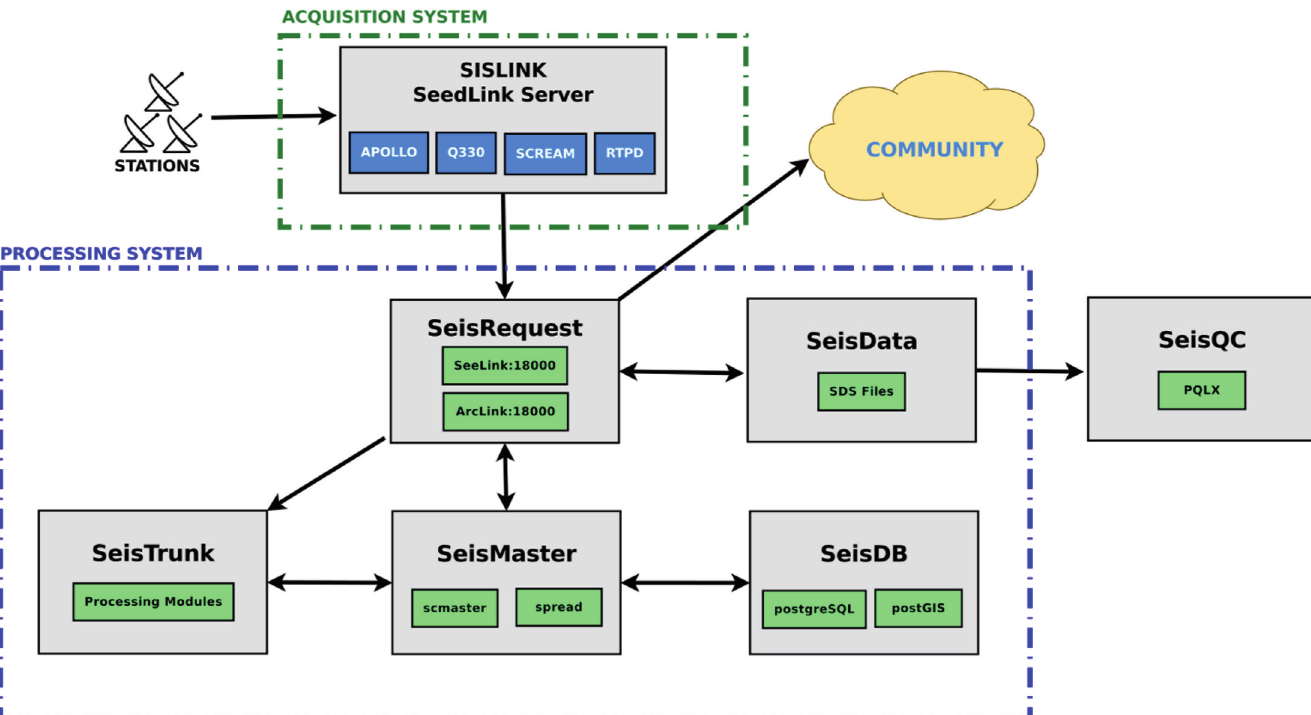
Figure 1. Schematic diagram of the SC3 acquisition and processing systems at the